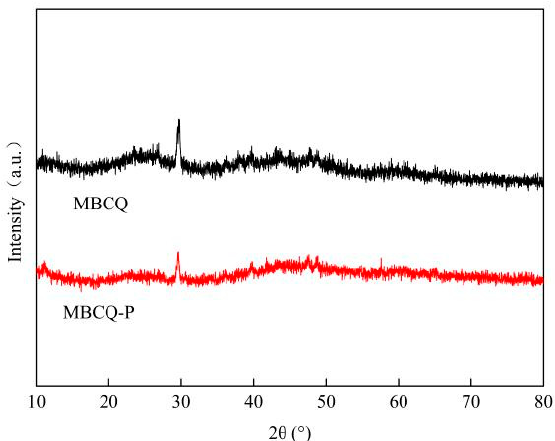
Figure 11. XRD diagram of MBCQ before and after phosphorus adsorption.